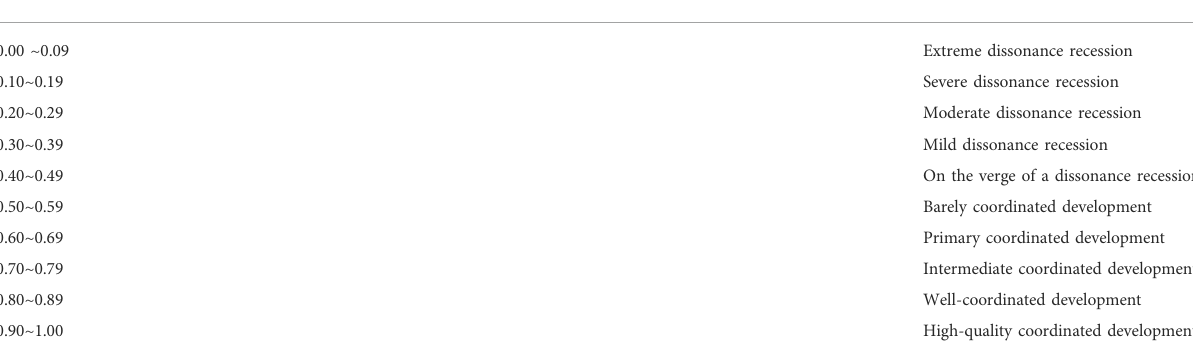
TABLE 4 The discriminant standard and classi fi cation type of coupling coordination